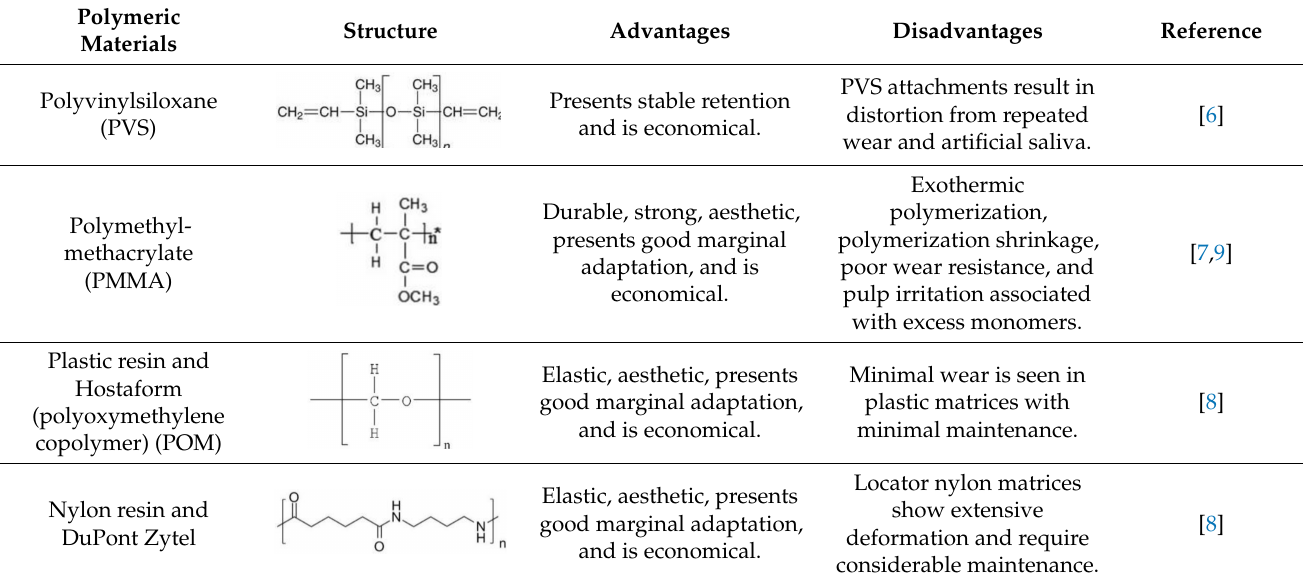
Table 1. Various polymeric materials used for attachment systems in